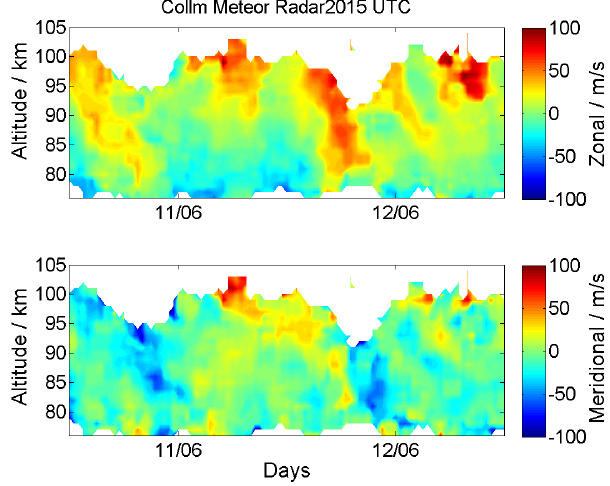
Figure 8. Zonal and meridional wind as observed by the Collm me- teor radar approximately 350km south of the CW radio link be- tween Juliusruh and